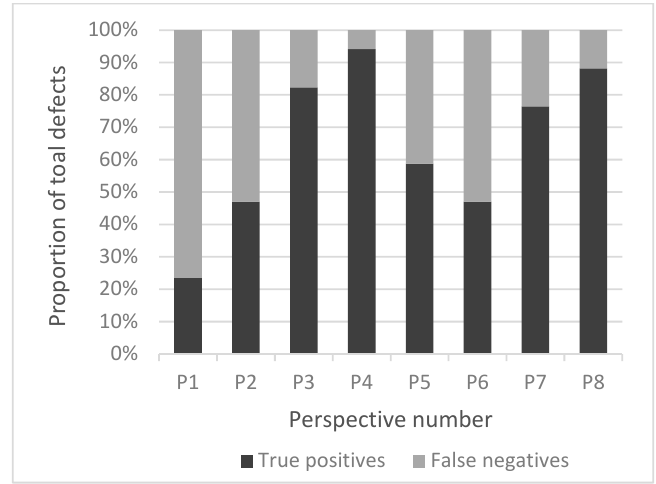
Figure 14. True positives and false positives proportions per perspective.